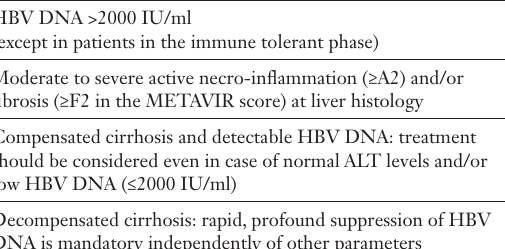
Serum ALT levels > upper level of the